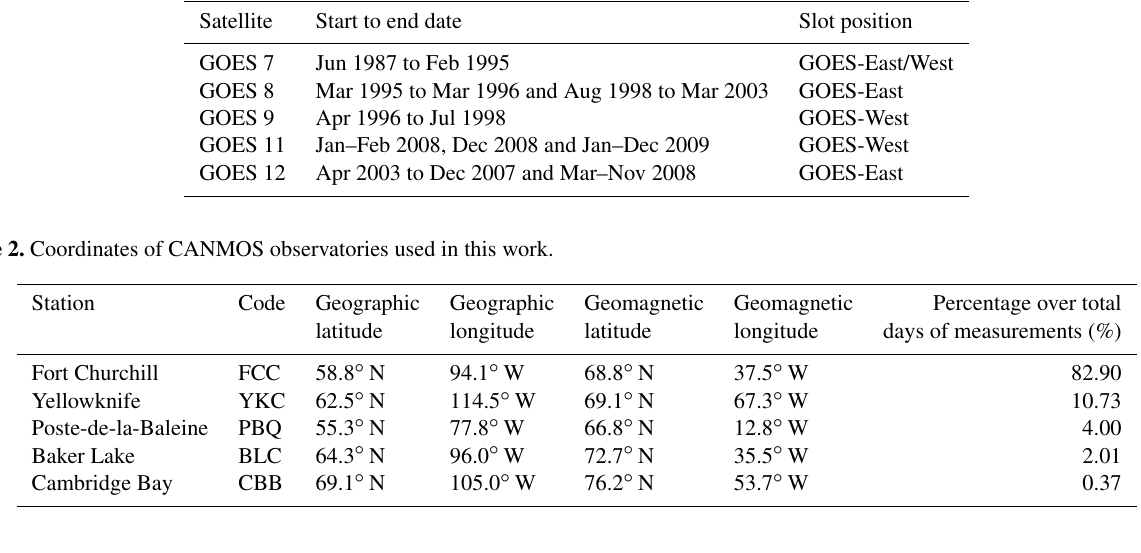
Table 1. Satellite data used in this study.